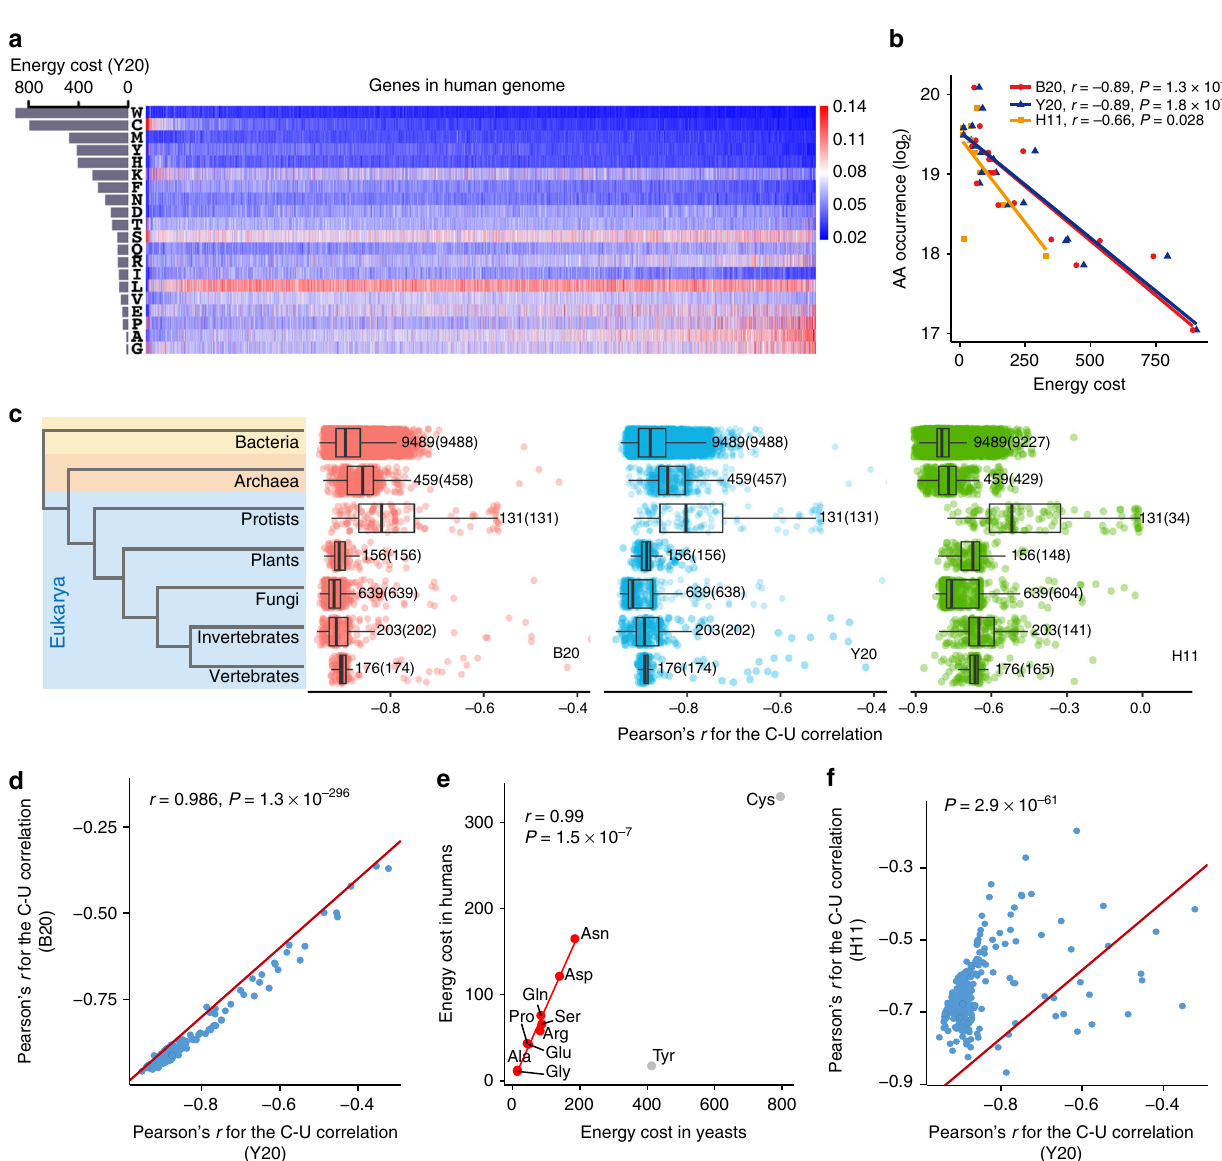
Fig. 1 Biosynthetic cost of AAs is correlated with AA usage in protein sequences. a Proportions of 20 AAs in human proteins. Bar plot on the left shows the biosynthetic cost of each AA (Y20). b The relationship between AA occurrences (log 2 ) in all human protein sequences and cost of AAs (red point, blue triangle and green square for B20, Y20, and H11, respectively). Pearson ’ s correlation test was performed. c Boxplots showing the distribution of Pearson ’ s r for the C – U correlation in seven major taxonomic groups in all domains of life. Phylogenetic tree at left shows the evolutionary relationship between the seven groups. The number of species in each of the seven groups is presented and the number of species showing signi fi cant C – U anticorrelation ( P < 0.05) is given in parentheses. Due to the conservation of cost metric or food chain, signi fi cant C – U anticorrelation was observed in all domains of life with three cost metrics (B20, Y20, and H11). Center line, median; box limits, upper and lower quartiles; whiskers, 1.5 times the interquartile range. d Pearson ’ s r for C – U correlation in animals based on Y20 ( x axis) is highly correlated with the corresponding value obtained with B20 ( y axis). The red line indicates where y = x . e Correlation between the biosynthetic costs of NEAAs in humans ( y axis) against those in yeast ( x axis). The nine AAs that can be synthesized from basic metabolites produced during glycolysis and TCA cycle (Ala, Asp, Asn, Arg, Gln, Glu, Gly, Pro, and Ser) are shown in red. The red line shows the results of the linear regression of biosynthetic costs of the nine AAs in humans against those in yeast. Biosynthesis of cysteine (Cys) and tyrosine (Tyr) depends on EAAs methionine and phenylalanine, respectively, and are displayed in gray. A signi fi cant correlation was still observed when incorporating Cys and Tyr in the analysis (Pearson ’ s r = 0.79 and P = 0.004 for all 11 NEAAs). f C – U anticorrelation in animals is weaker using H11 metric compared with Y20 metric (Wilcoxon ’ s signed-rank test, P = 3 × 10 − 61 ). The red line indicates where y =